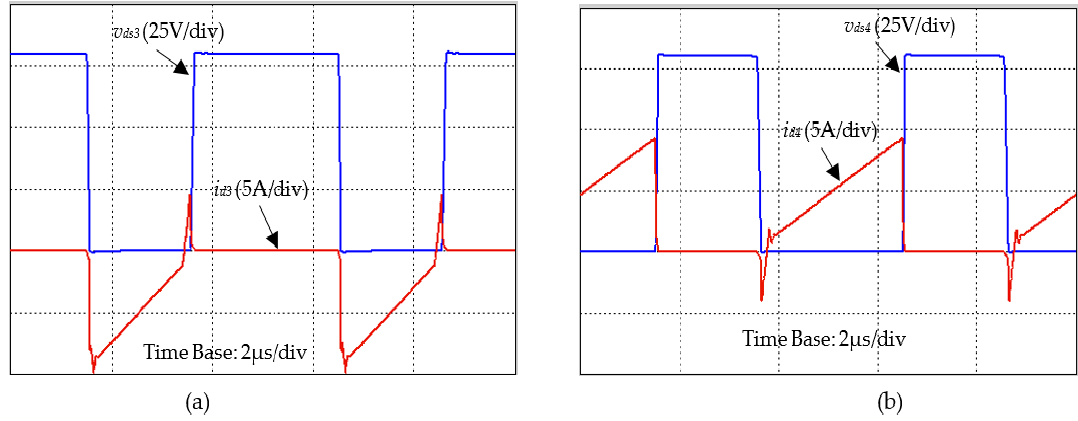
Figure 15. Simulation results of the current and voltage of the main switches when i o = 8 A. ( a ) S 3 ; ( b ) S 4 .